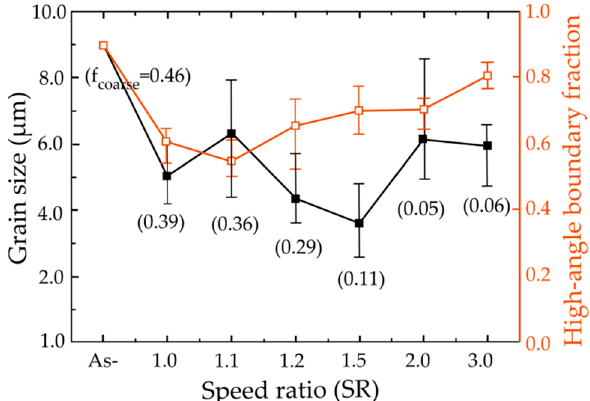
Figure 4. The average grain sizes and the average fractions of HAGBs, which were measured at the top, middle and bottom layers of the samples deformed at different SRs [ 40 ]. f coarse is related to the fraction of grains that have not fully refined. Reproduced with permission from Kim et al., J. Alloys Compd. ; published by Elsevier, 2011.